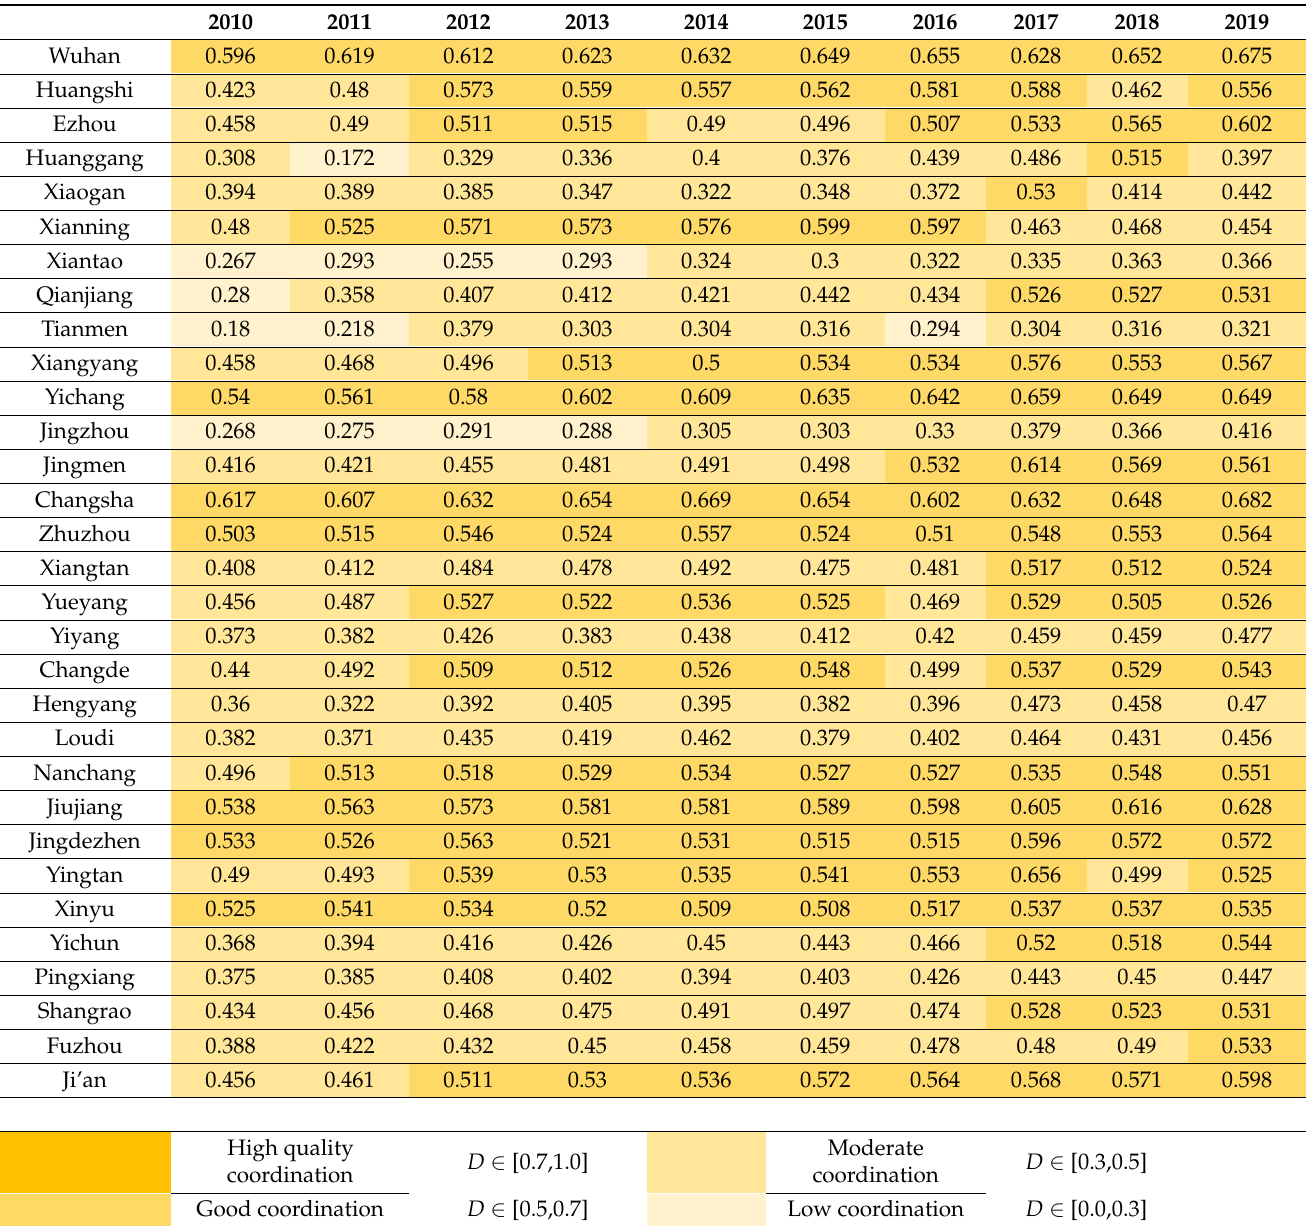
Table 5. Coupling coordination degree of each